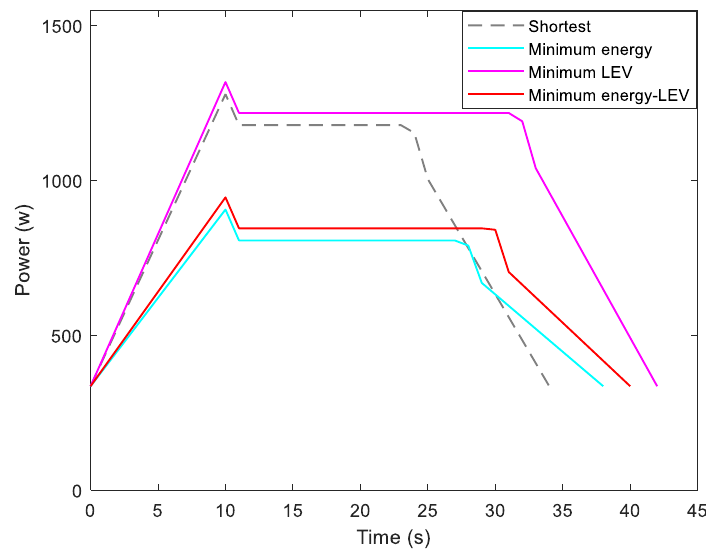
Figure 14. The LEV in the experiments. Figure 13. Motional power in the Figure 13. Motional power in the experiments.